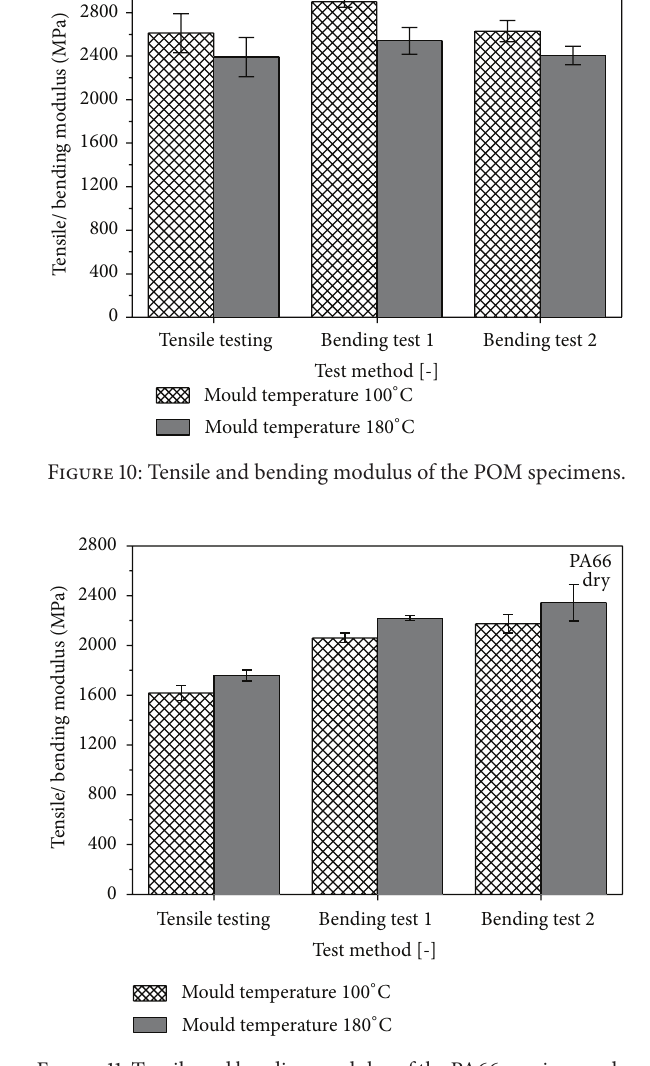
Figure 11: Tensile and bending modulus of the PA66 specimens, dry